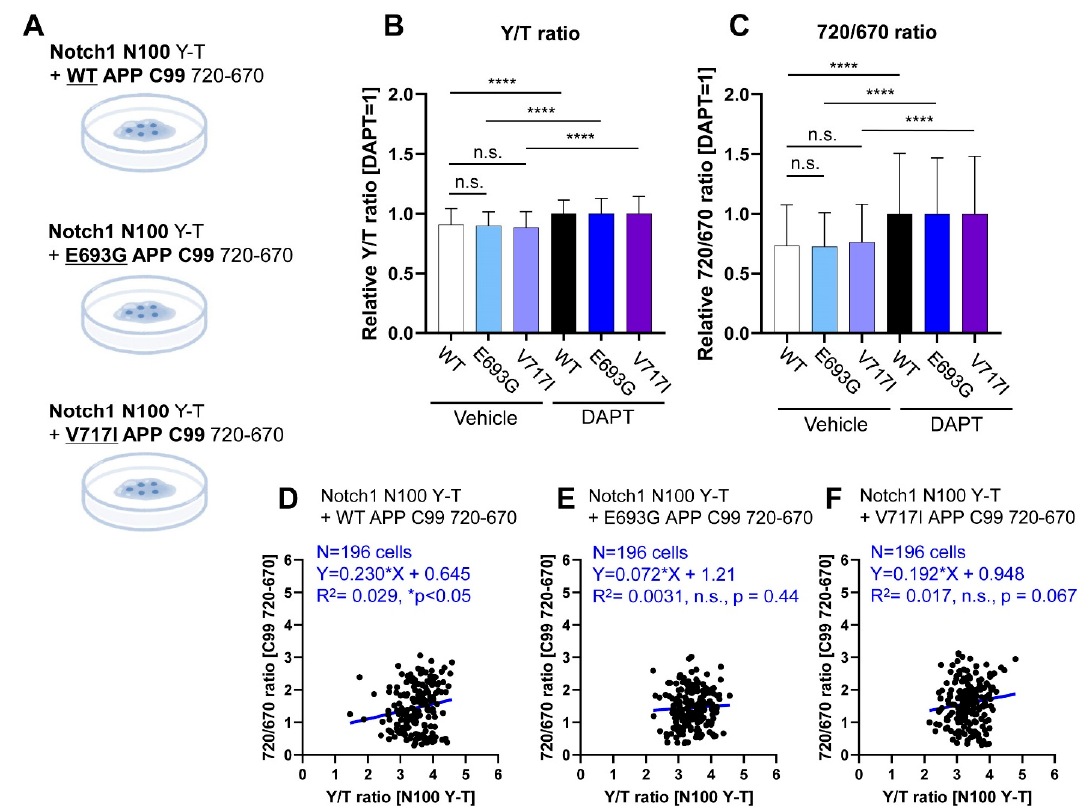
Figure 3. Co-monitoring of Notch1 N100 and FAD-linked mutants APP C99 processing by PS/ γ -secretase. ( A ) Schematic representation of the experimental conditions: the Notch1 N100 Y-T biosensor was co-transfected into CHO cells with the WT or FAD mutants C99 720-670 biosensors; ( B ) There is no significant difference in the Y/T ratios of N100 Y-T biosensor in the presence of FAD mutants E693G or V717I C99 720-670 probes. n = 196, one-way ANOVA, n.s. not significant, **** p < 0.0001; ( C ) Similarly, there is no change between the processing of WT versus the FAD mutants C99 720-670. n = 196, one-way ANOVA, n.s. not significant, **** p < 0.0001. Scatterplot of Y/T ratios with 720/670 ratios in the cells expressing the N100 Y-T and ( D ) WT C99 720-670 ( n = 196, Y = 0.23X + 0.645, R 2 = 0.029, * p < 0.05); ( E ) E693G C99 720-670 ( n = 196, Y = 0.072X + 1.21, R 2 = 0.003, n.s. p = 0.44); or ( F ) V717I C99 720-670 biosensors ( n = 196, Y = 0.192X + 0.948, R 2 = 0.017, n.s. p = 0.067).